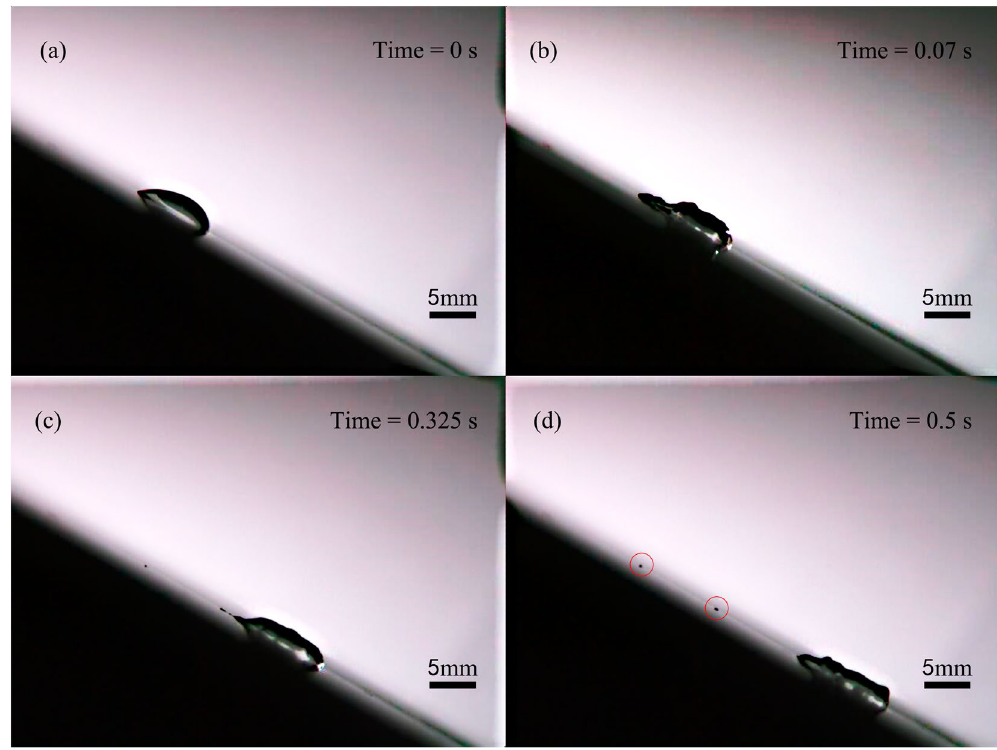
Figure 2. Experimental observation for a 30 μ l droplet placed on a 1 mm thick inclined glass plate at an inclination angle of 30° at a wave amplitude of 17.95 nm (measured by laser-Doppler vibrometry) produced by a 1 MHz single phase transducer (SPT) at an input AC voltage 95 V pp . The observations are snapshots from video sequences recorded with a high-speed camera. The waves are propagating from left to right. ( a ) The initial state was at 0 s, ( b ) the droplet first becomes in a longitudinal expansion at the bottom, ( c ) above a critical speed, the trailing end breaks up to a pearl, ( d ) two pearl drops are pinned on the glass